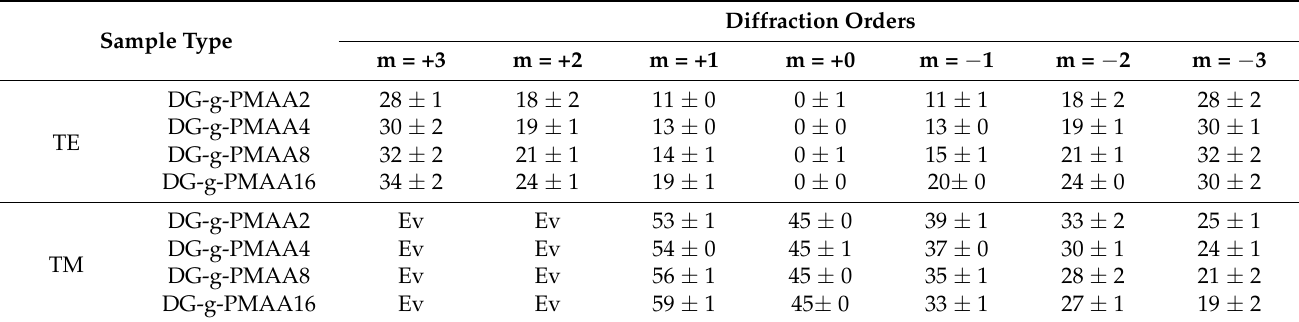
Table 1. Diffraction angles, θ m ( ◦ ), of reflective STP DGs at a 45 ◦ incident angle using a 532 nm laser beam. Evanescent spatiotemporal orders are represented by “Ev”. Each measurement was repeated independently three times. Sample